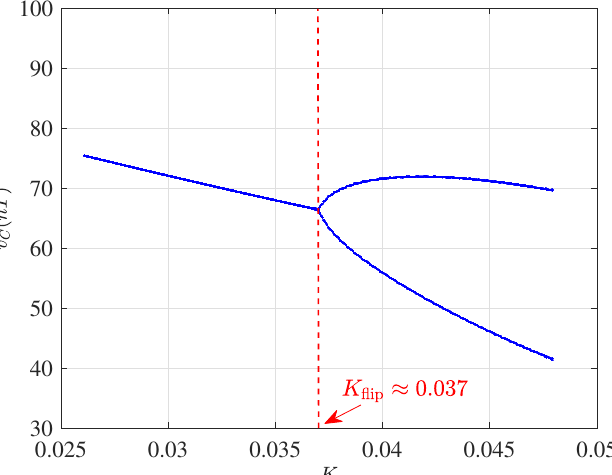
Figure 12. Bifurcation diagram of the DCM-operated buck converter with a CPL obtained using the PSIM ©